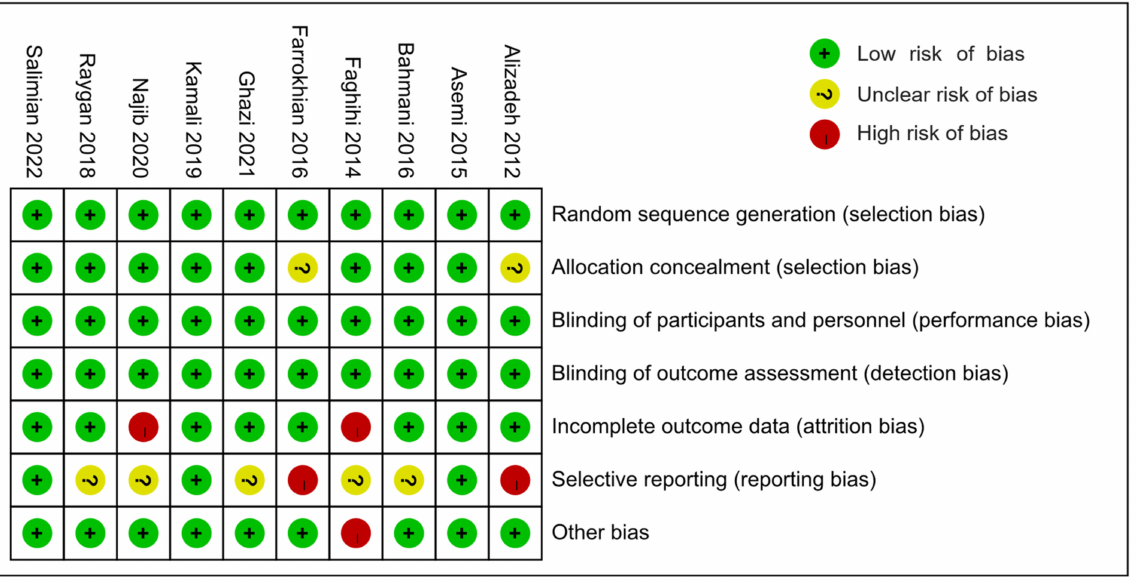
Figure 2. Summary of the risks of